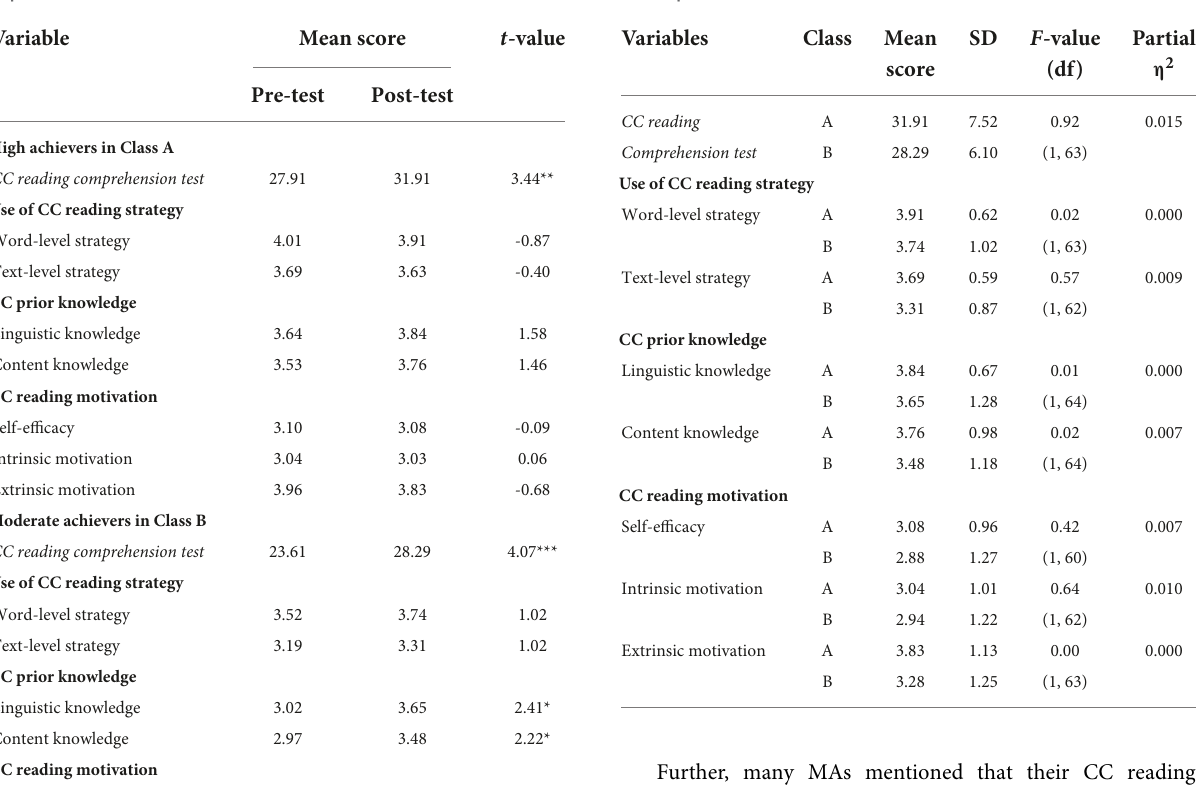
TABLE 4 Group comparisons on the post-test measures among the two experimental